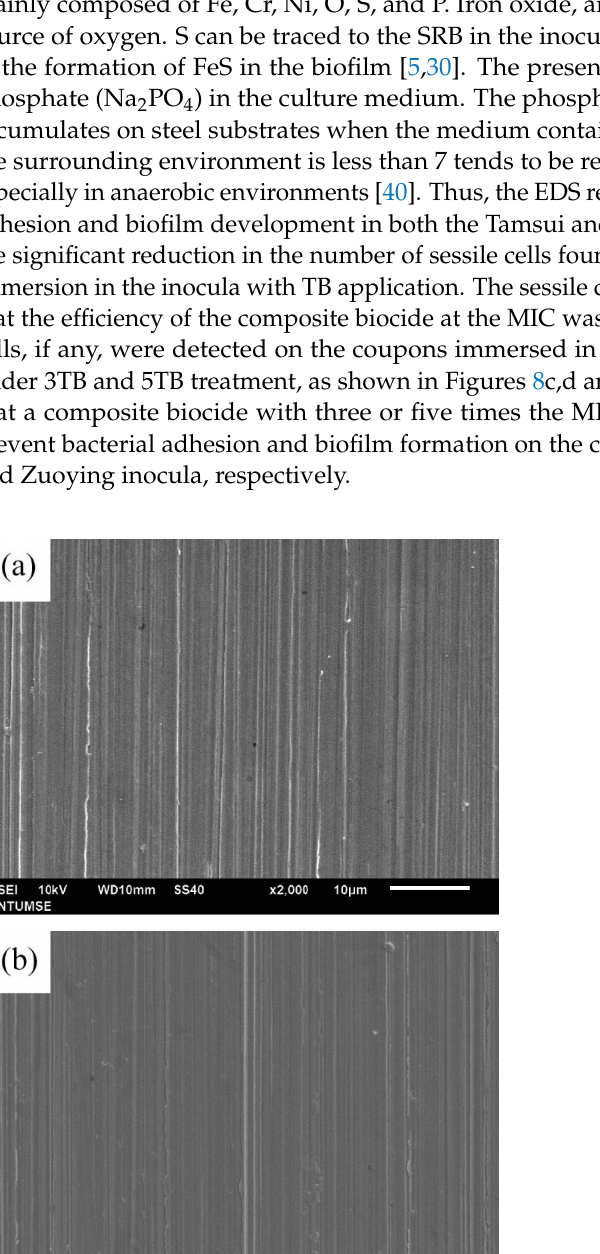
Figure 7. SEM images of the 304 SS surface after 12 h of exposure to ( a ) the uninoculated Tamsui medium, ( b ) TB, ( c ) 3TB, and ( d ) 5TB, presenting enlargements of areas with biofilm formation.